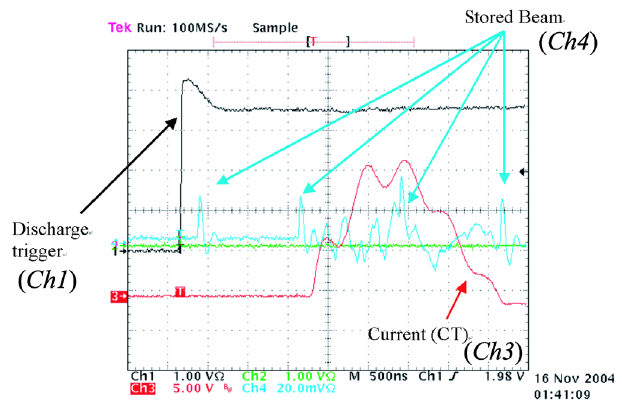
FIG. 19. (Color) Field strength distribution measured at the horizontal position of 15 mm from the pole center as a function of the longitudinal position. The measurement is carried out using a short coil. The blue solid and red dotted lines represent the measured results with and without a vacuum chamber, respectively. Since the chamber is almost symmetric, the mea- surement with the chamber is carried out on only one side of the magnet.